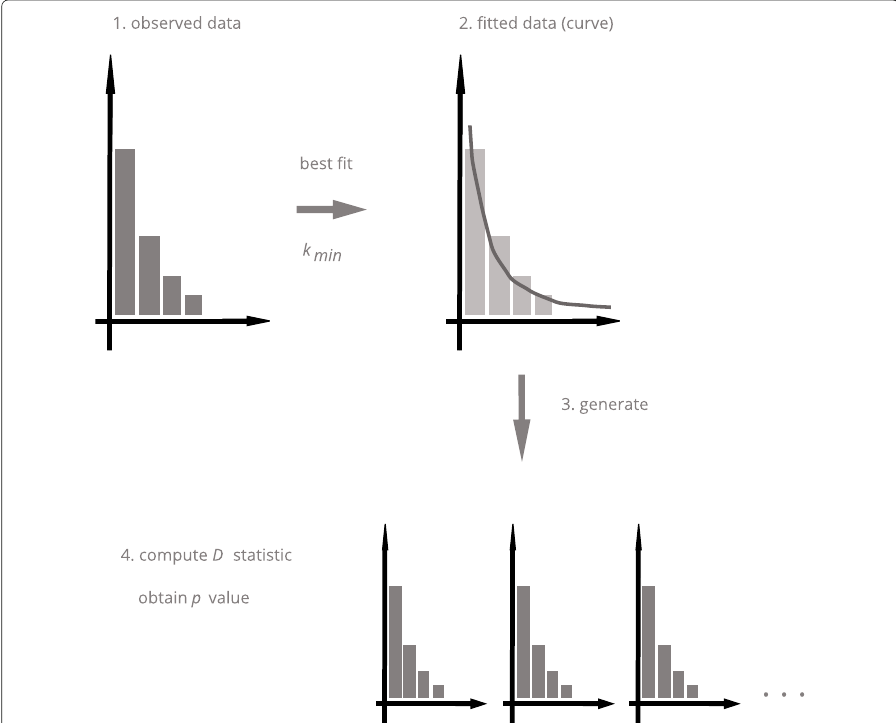
Fig. 2 The basic experiment workflow. After fitting the observed data, artificial datasets are generated according to the fit function. The null hypothesis is then accepted or rejected based on the p -value derived from the D